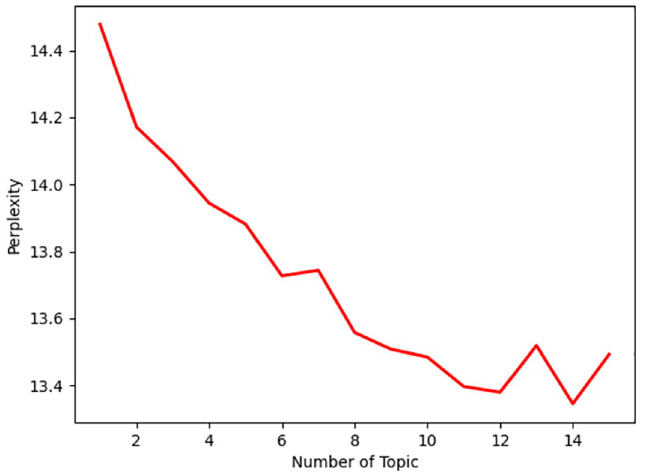
Fig 2. Topic perplexity of the LDA